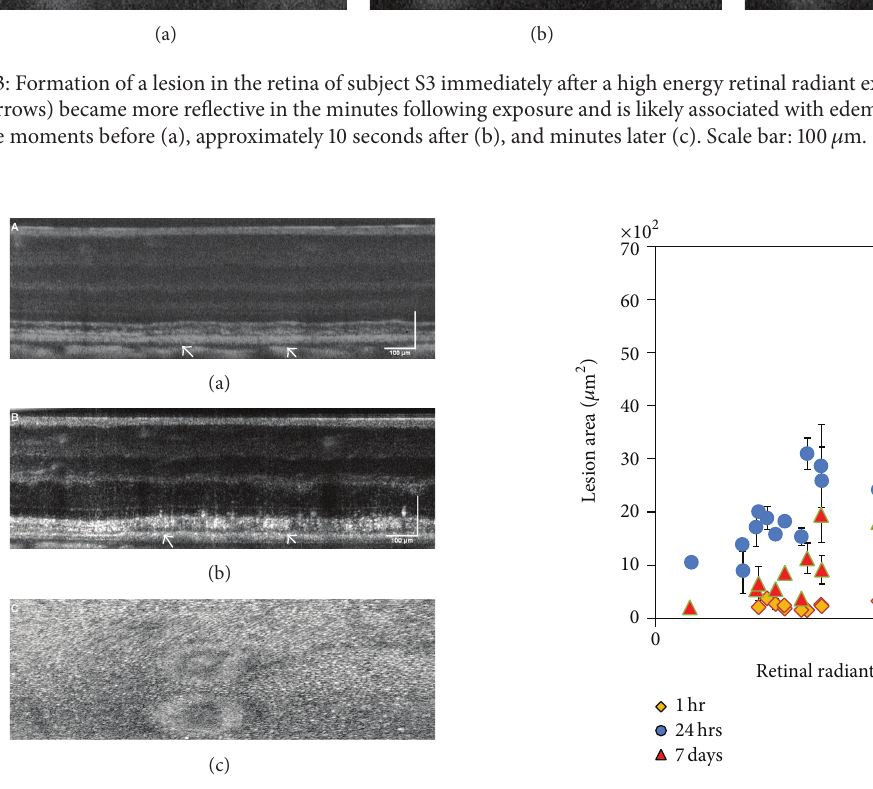
Figure 5: Picosecond lesions area grew (measured using AO SD- OCT)insizeproportionaltoincreasingenergymeasured(datafrom one